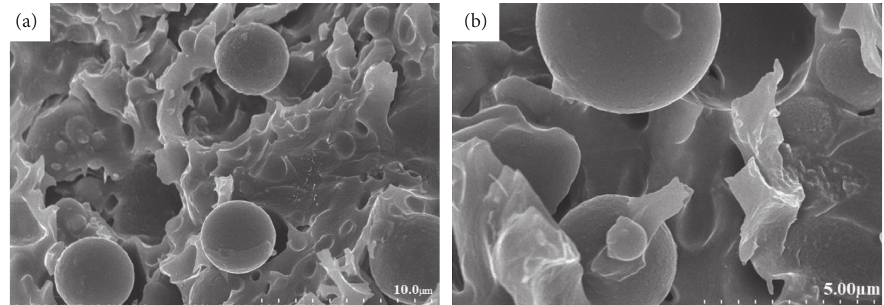
Figure 3: SEM images of nanocomposites: 30 wt.% fly ash/0.03 wt.% MWCNTs/epoxy ((a), (b)).